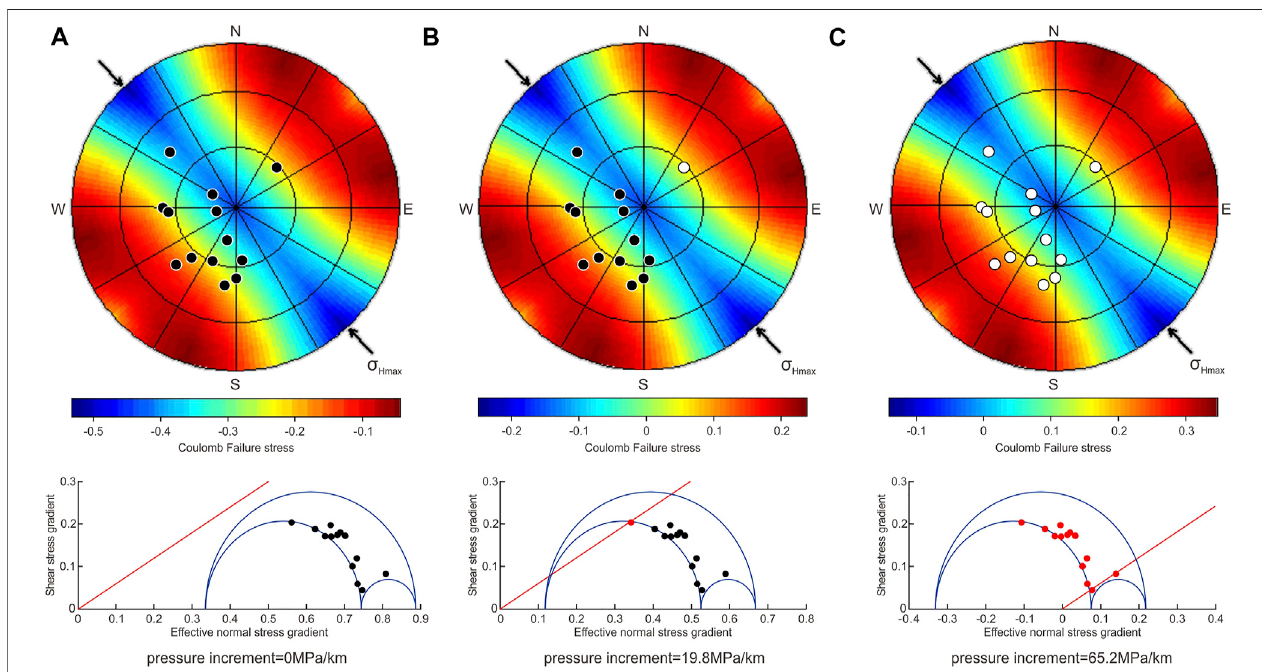
FIGURE 15 | Fracture effective analysis in low-permeability sandstones in LD-A gas fi eld. (A) The pressure increment is 0 MPa/km, (B) The pressure increment is 19.8 MPa/km, and (C) The pressure increment is 65.2 MPa/km.